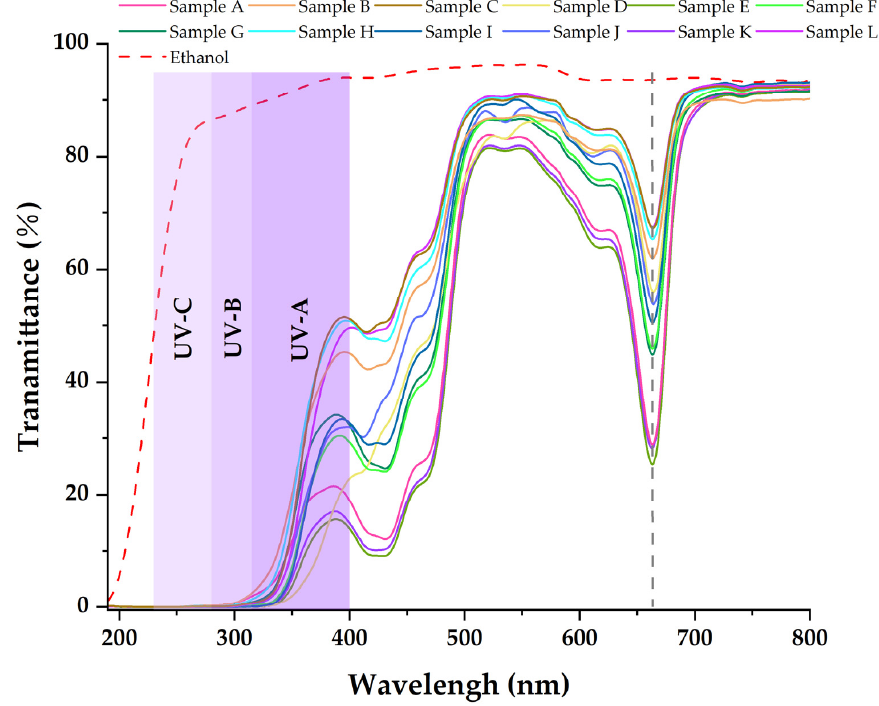
Figure 5. Transmittance spectra of the ethanol extractives from Alnus cremastogyne pods.